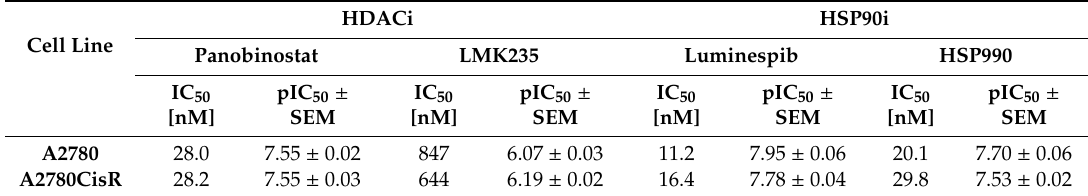
Table 1. Cytotoxic activity of panobinostat, LMK235, luminespib and